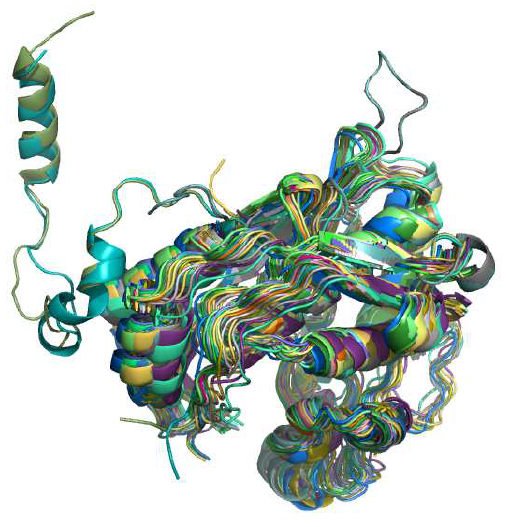
Figure 6. A multiple alignment produced by LaJolla using chain B of Thymidylate Synthase with PDB ID 2TSC against all other Thymidylate